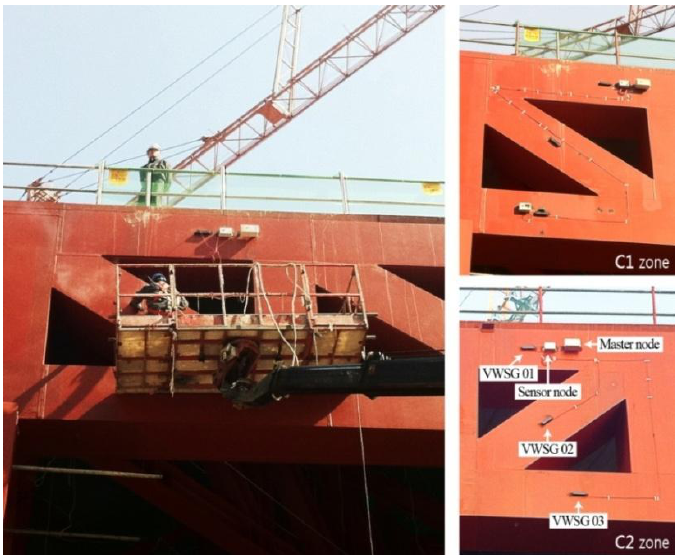
Figure 9. Installation of sensors in zone